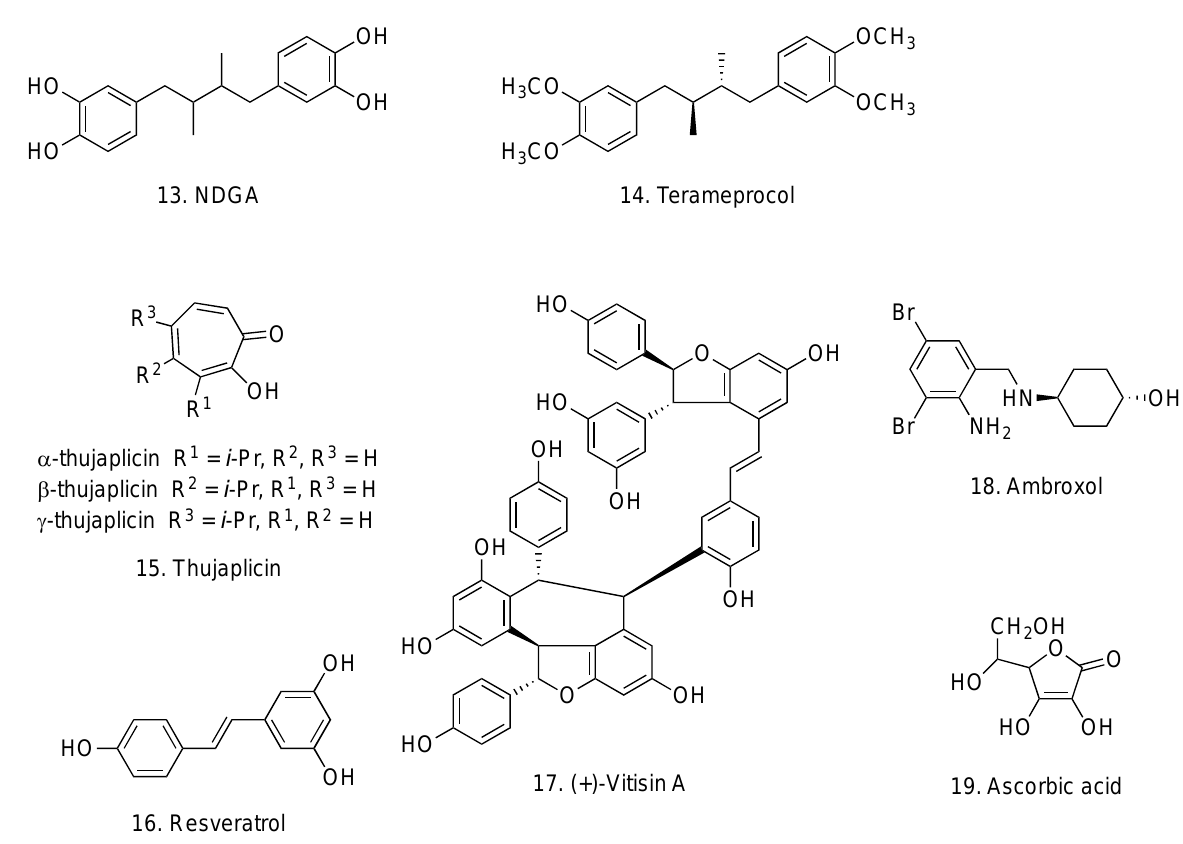
Figure 4. Hydroxyl antioxidants with anti-influenza virus